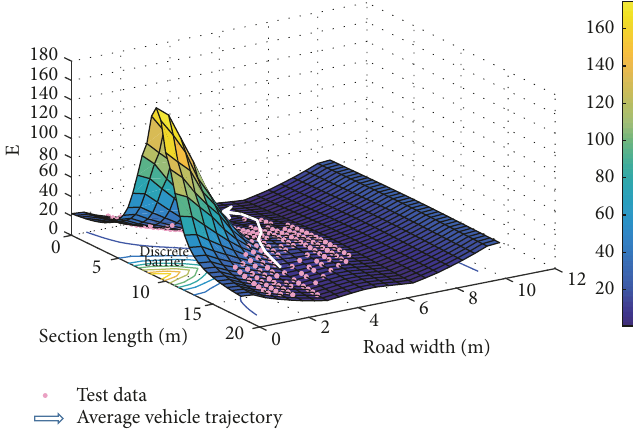
Figure 8: Vehicle trajectories in 3D field strength diagram.